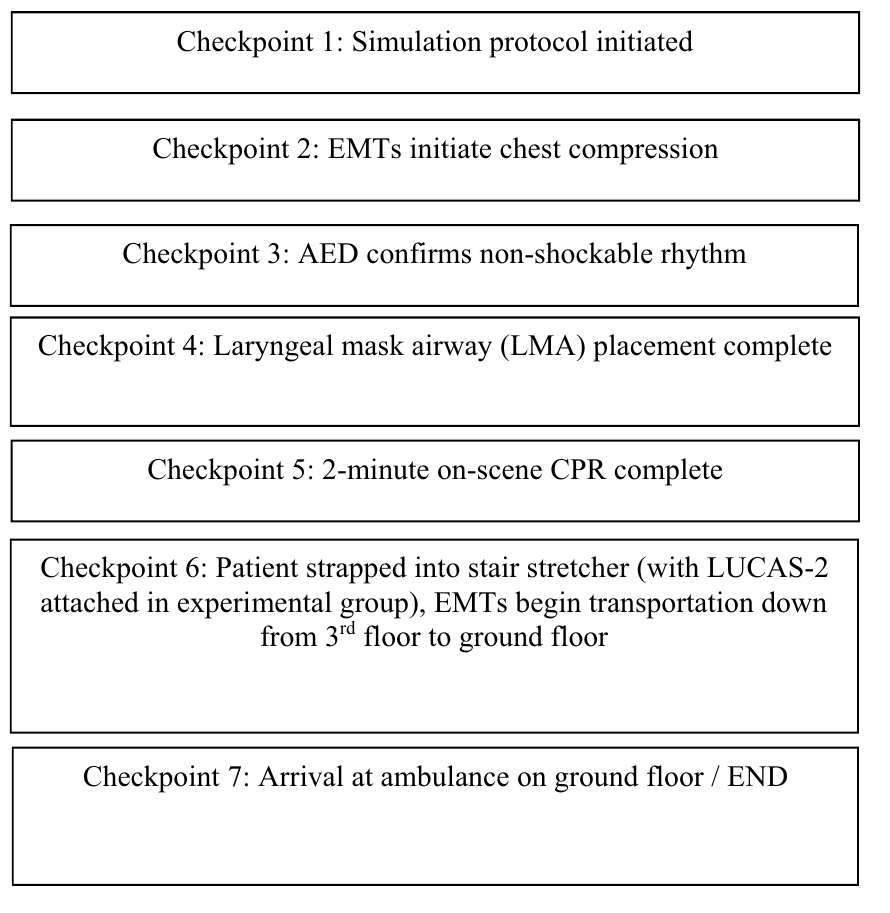
Figure 2. Different checkpoints of simulation